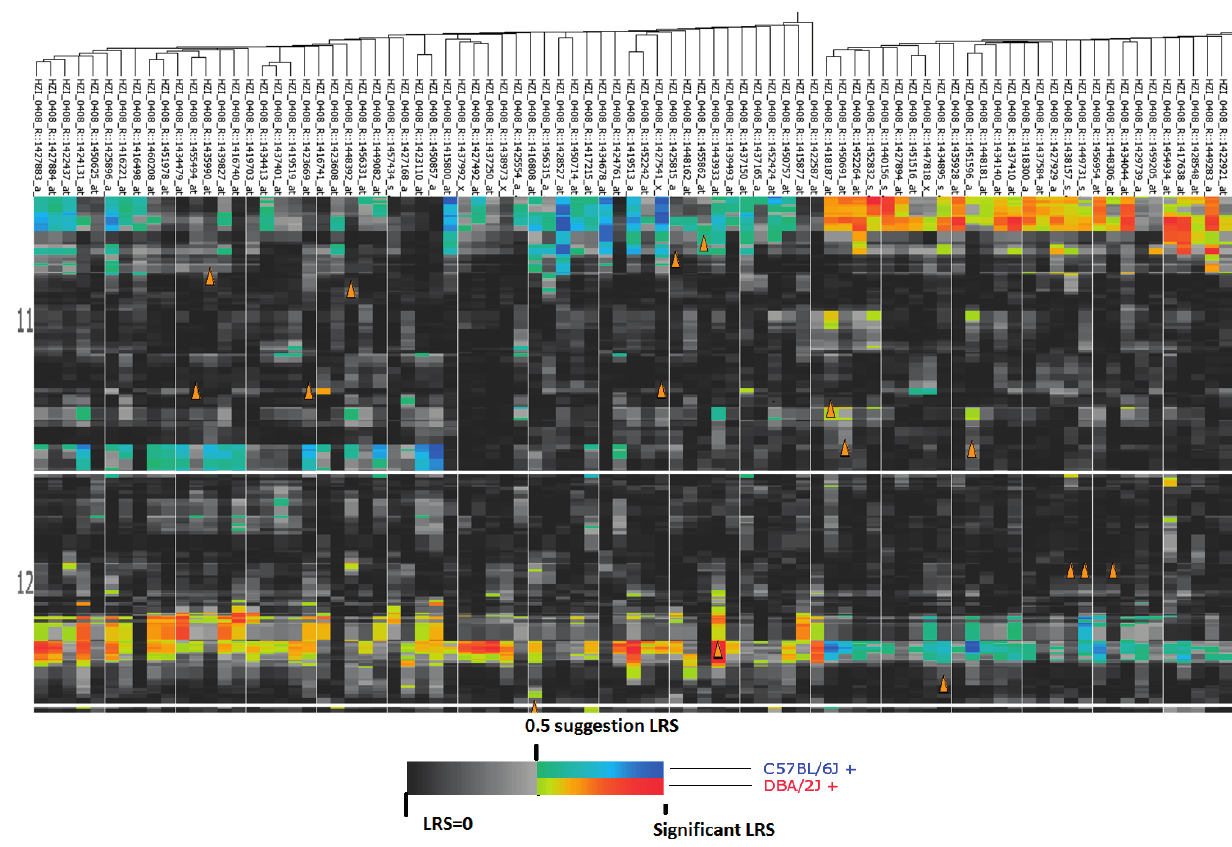
Figure 3. Heatmap showing regulation of genes on Chr 11 and 12 that are closely correlated to Col3a1 . The influence of these two Chrs. On Chr 11 expression of first part of genes are affected by C57BL/6J (B6) and the last part of the genes are affected by DBA/2J (D2), while on Chr 12, the effect is opposite to that on Chr 11. Orange triangles are genetic elements (probes) that are correlated to the expression level of